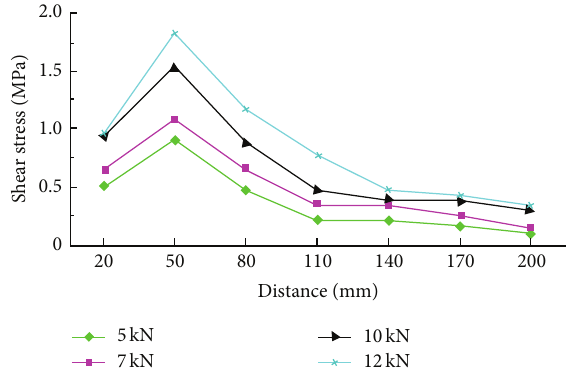
Figure 8: Shear stress distribution.